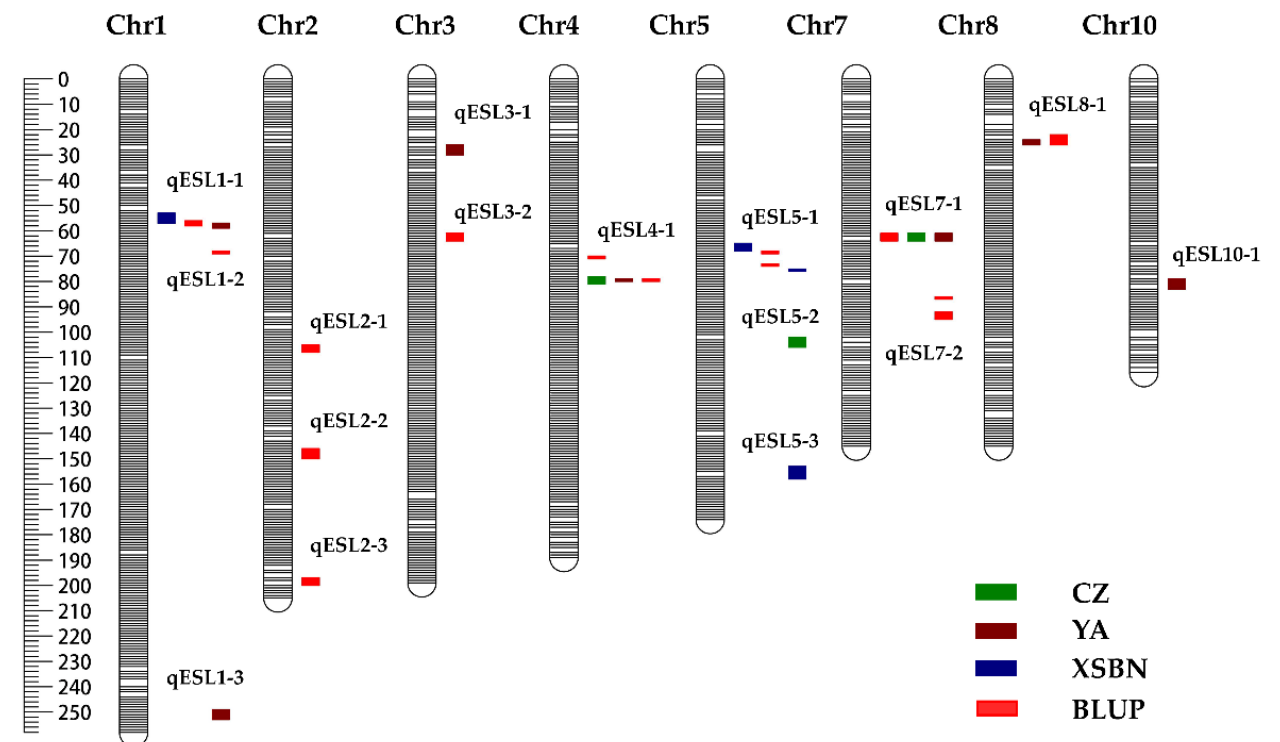
Figure 2. Chromosomal distributions of the QTL for ear shank length in the IBM Syn10 DH population in three environments. Chr1–Chr10 represent chromosomes 1–10. ESL denotes ear shank length. CZ, YA, and XSBN represent the environments Chongzhou, Ya’an, and Xishuangbanna, re- spectively. BLUP, best linear unbiased prediction.